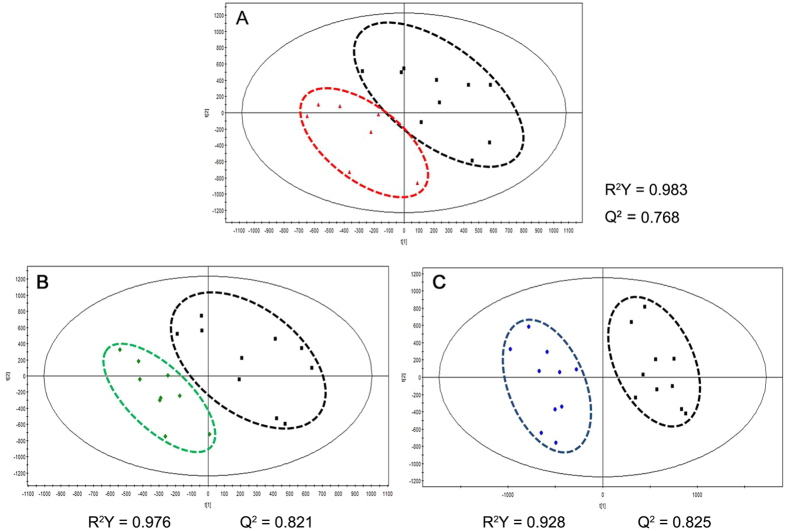
Scoring plots of metabolites from rat testis with PLS-DA model under positive ion mode. Control;  1 mg/L;  5 mg/L;  25 mg/L